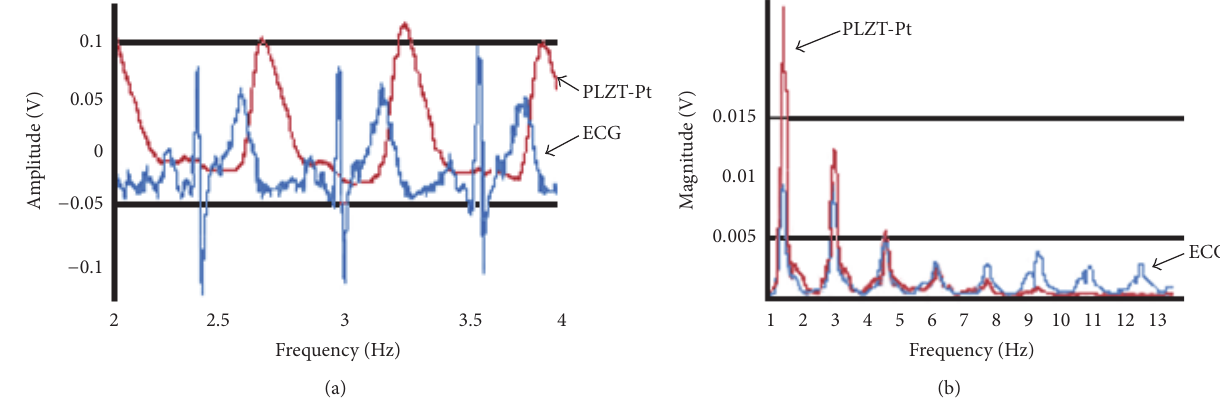
Figure 10: (a) ECG signal register and cardiac pulses monitor in effort condition and (b) frequency spectrum recorded with effort